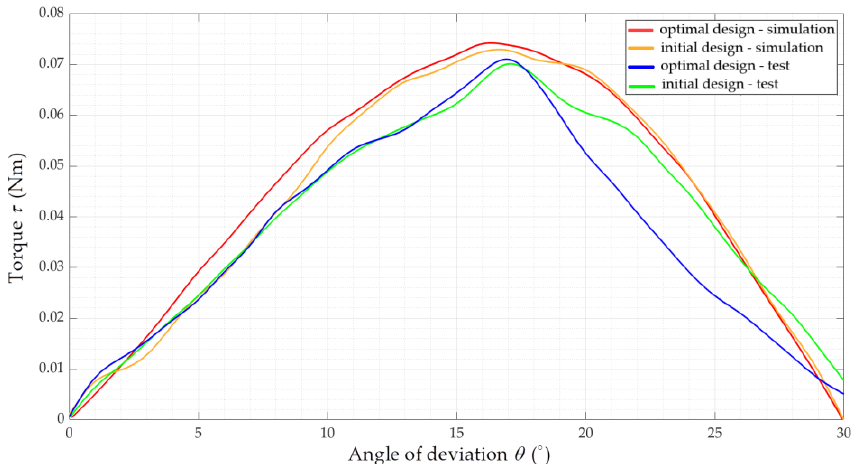
Figure 14. Test results for the initial and optimal designs of the coupling.